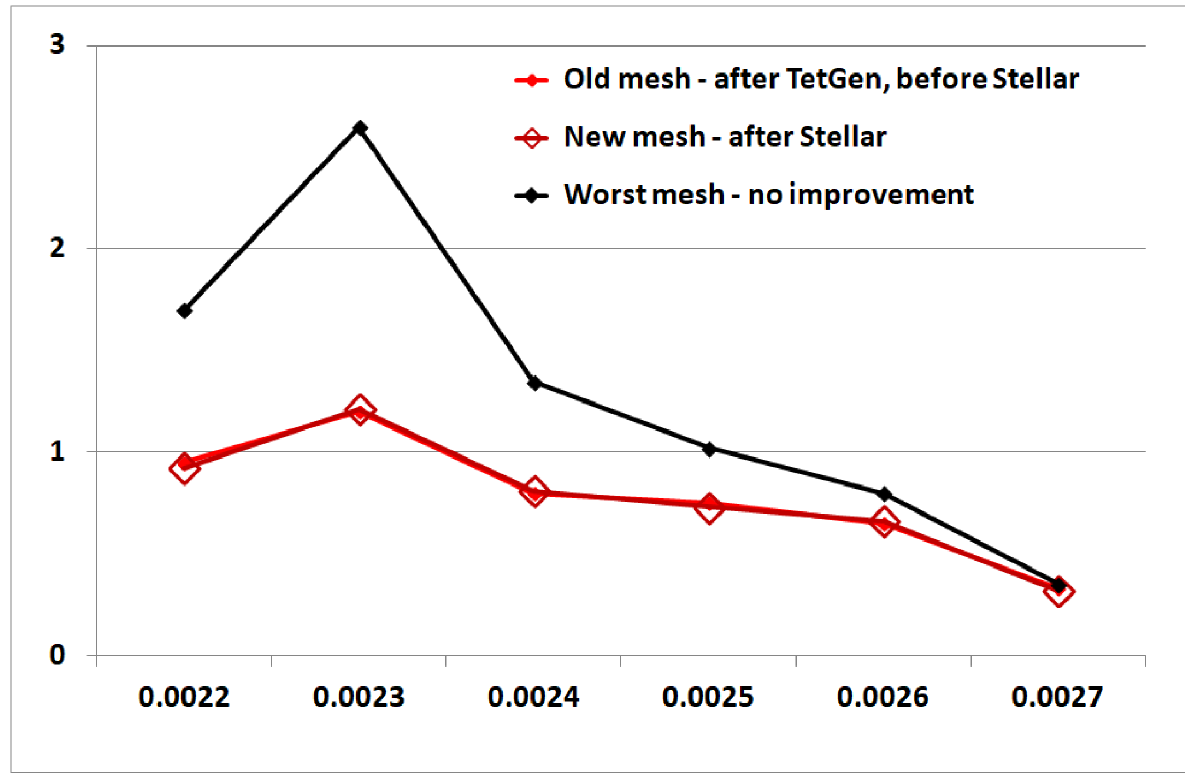
Figure 13. Comparison of simulation results for three various meshes. The plot represents the amount of neurotransmitter released during stimulation by a single incoming electrical